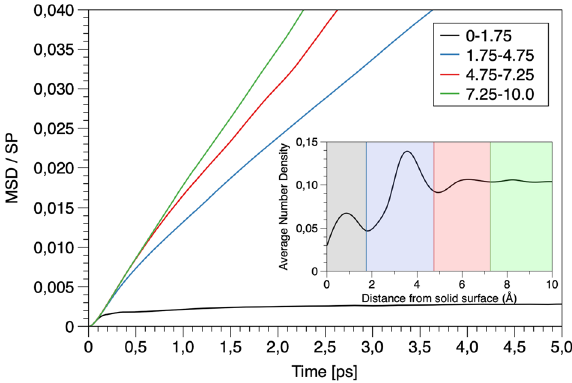
Figure 6. Parallel mean square displacement (MSD) divided by the survival probability (SP) for specific water layers from the zirconia interface at (− 111) face. The parallel MSD is defined as the average MSD values in x and y directions. The self-diffusion coefficients for the four layers are 8.06 × 10 −13 m 2 /s, 1.6 × 10 −9 m 2 /s, 2.4 × 10 −9 m 2 /s and 4.02 × 10 −9 m 2 /s,